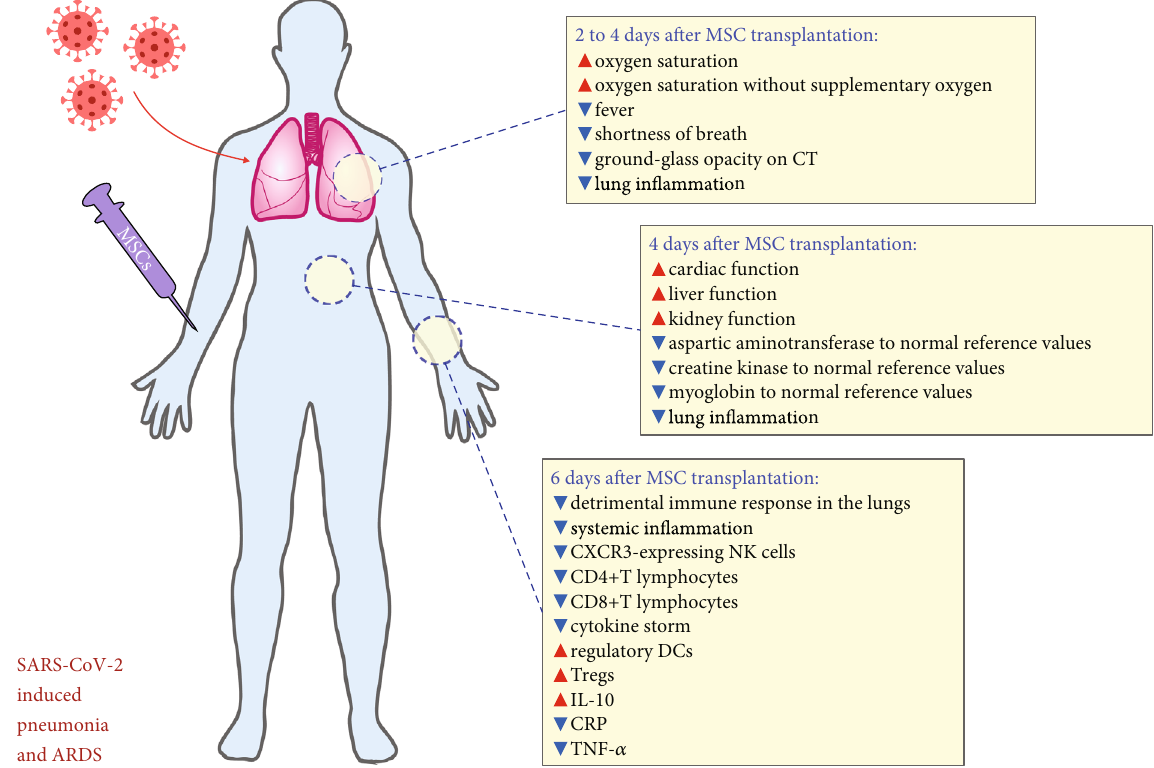
Figure 3: MSC-based e ff ects observed in a patient with critically severe COVID-19 infection. MSCs signi fi cantly improved oxygenation, suppressed detrimental immune response in the lungs, alleviated systemic in fl ammation, and attenuated SARS-CoV-2 induced ARDS in a patient with critically severe COVID-19